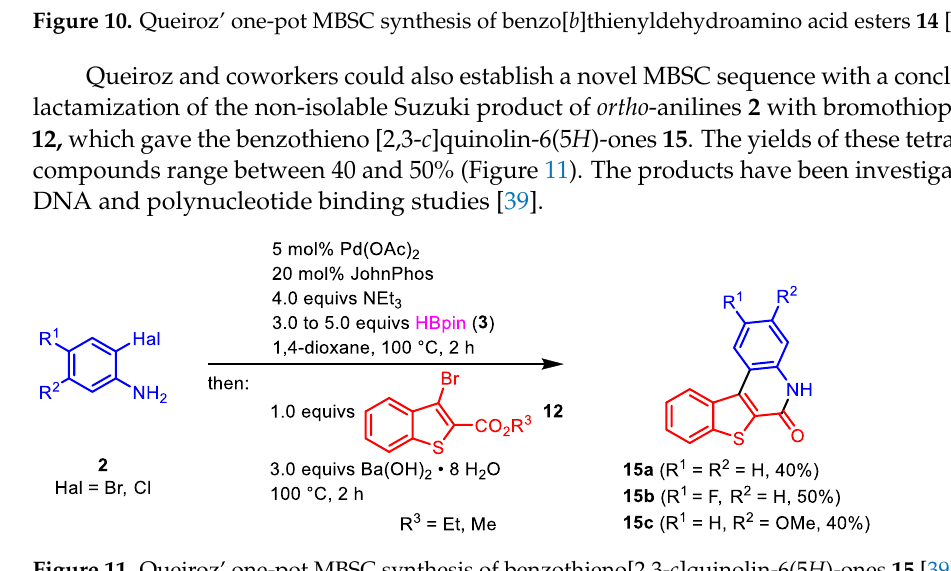
Figure 11. Queiroz ’ one-pot MBSC synthesis of benzothieno[2,3- c ]quinolin-6(5 H )-ones 15 [39].